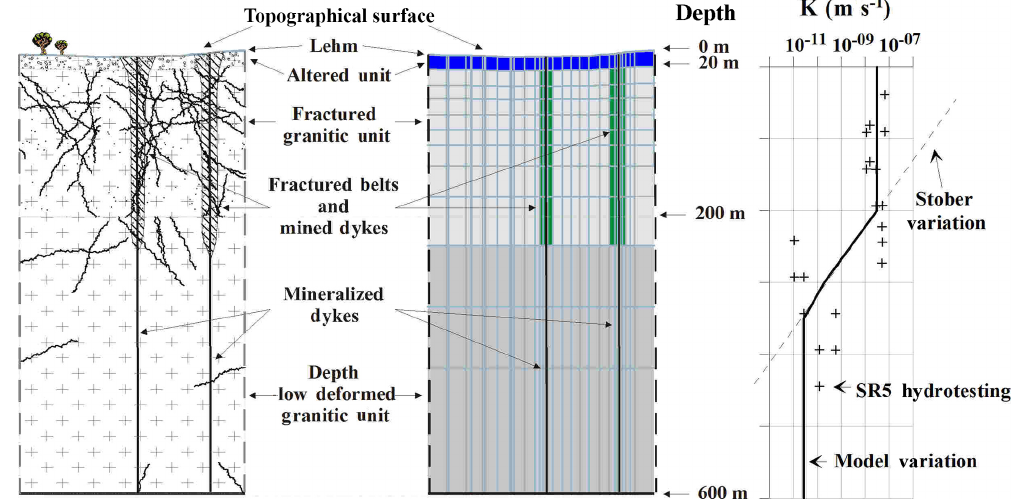
Figure 7. Schematic vertical section representing variations in data derived from the hydraulic characterization of borehole SR5 (500m deep) indicate that hydraulic conductivity changes with depth. This fact was studied by Stober (1997). The model uses a modification of Stober’s equation: hydraulic conductivity is kept constant up to the base of the fractured granitic unit (200m), then changes with depth down to 350m. From there, it remains constant down to the model bottom.